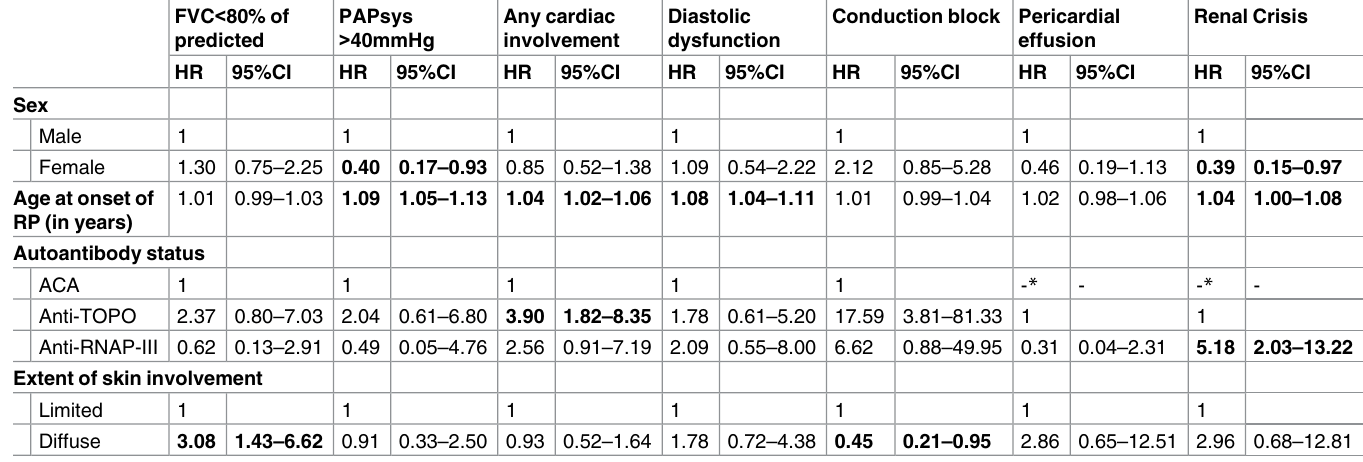
Table 3. Cox multivariable regression analysis of risk factors for the time to incident FVC < 80% of predicted, PAPsys > 40mmHg, any cardiac dys- function, diastolic dysfunction, conduction block, pericardial effusion and renal crisis. ACA, anti-centromere autoantibodies; Anti-RNAP-III, anti- RNA-polymerase-III autoantibodies; Anti-TOPO, anti-topoisomerase-I autoantibodies; cardiac involvement, definedas either the presence of diastolicdys- function, conduction blocks, left ventricularejection fraction (LVEF) < 50%, or pericardialeffusion; CI, confidence interval; FVC, forced vital capacity; HR, haz- ard ratio; PAPsys, systolic pulmonaryartery pressure as estimated by echocardiography; RP, Raynaud’s